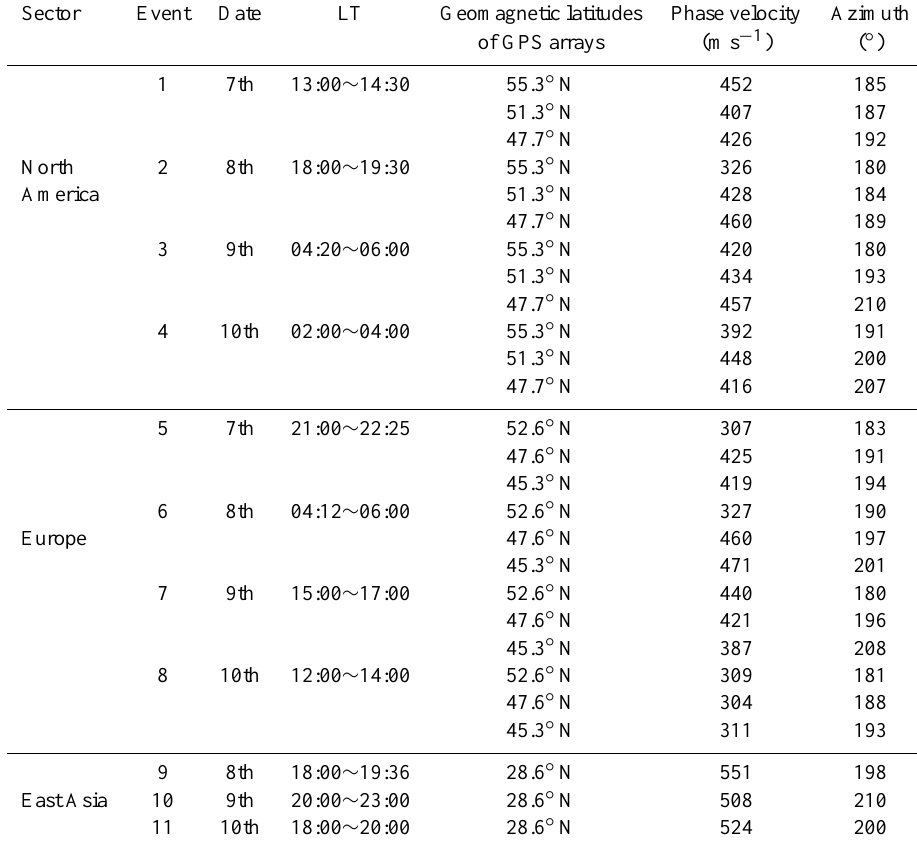
Table 2. Summary of the horizontal phase velocities and propagation azimuths of the 11 LSTIDs events detected from 7 chosen GPS arrays in the three given sectors during the magnetic storm on 7 ∼ 10 November